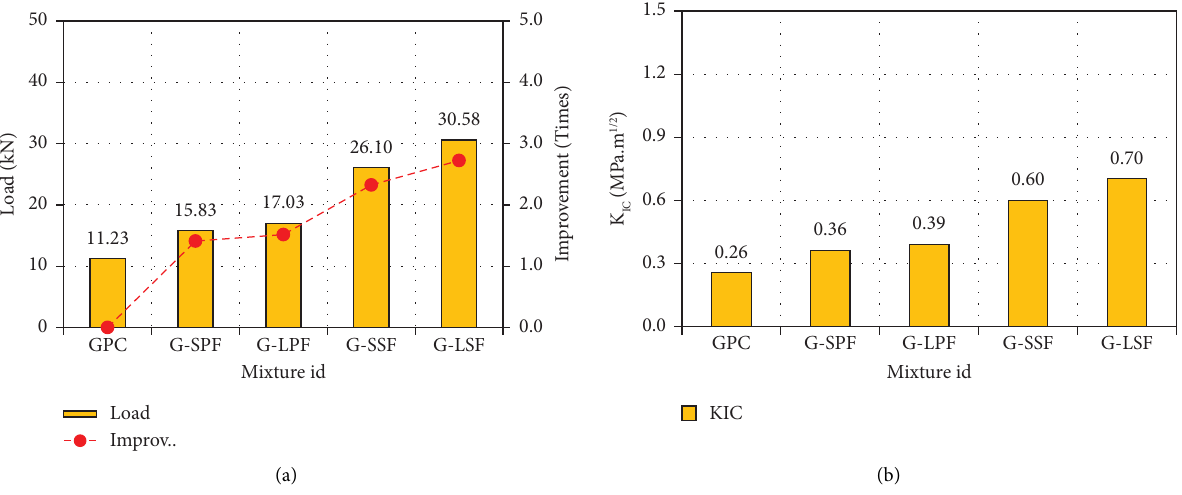
Figure 8: Mode I fracture toughness of specimens under 0 ° loading.